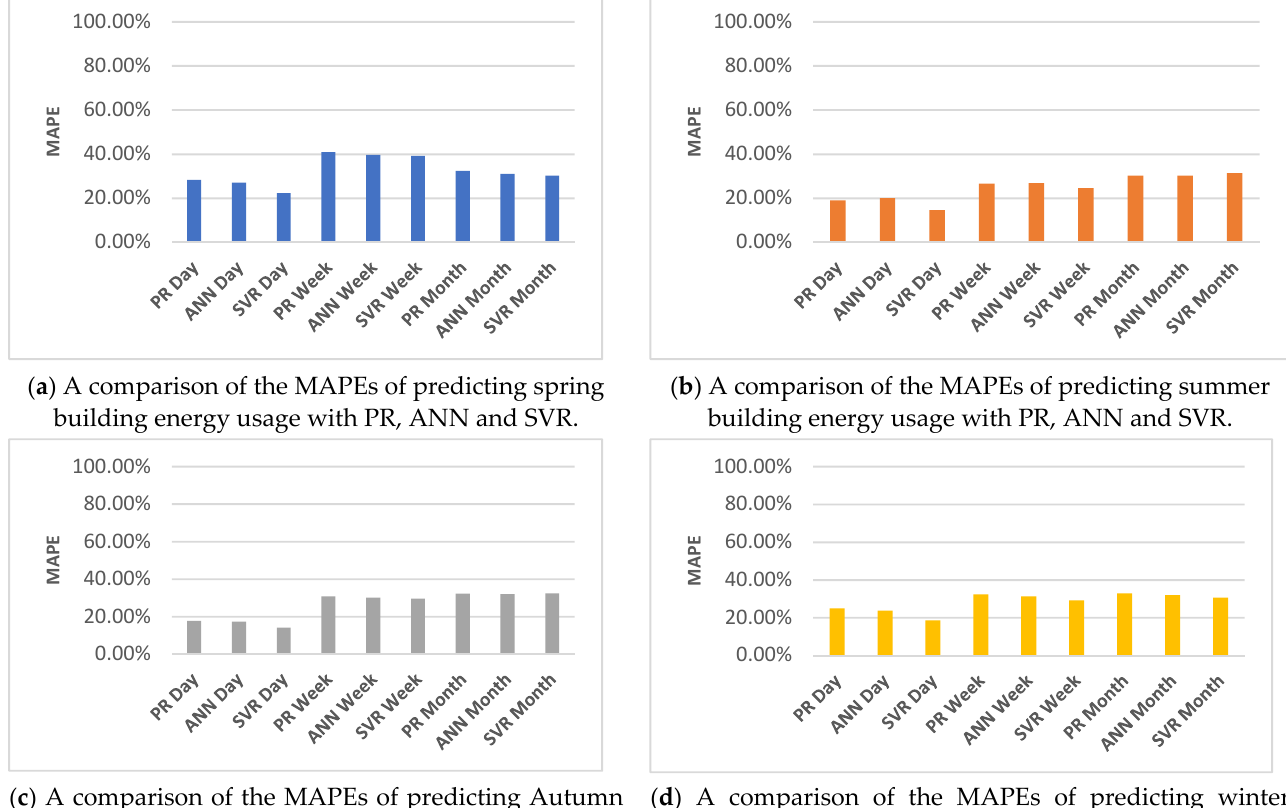
Figure 19. A comparison of daily, weekly, and monthly predictions’ MAPEs produced by the machine learning tech- niques.